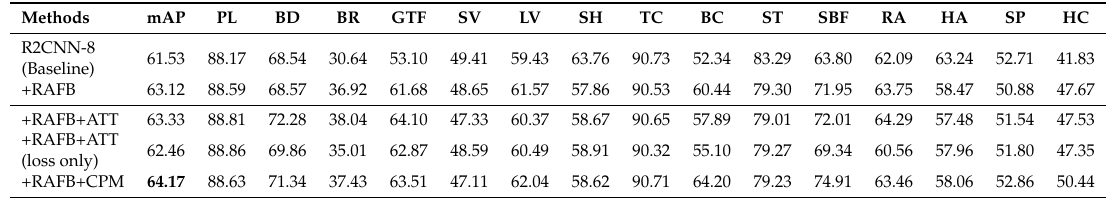
Table 2. The effect of each component in the proposed method on the DOTA dataset (%), where “RAFB” indicates the rotational anchor-free branch; “Att” is the attention module and “CPM” denotes the center prediction module. “Loss only” means that the attention module is only applied during training, as an auxiliary loss.